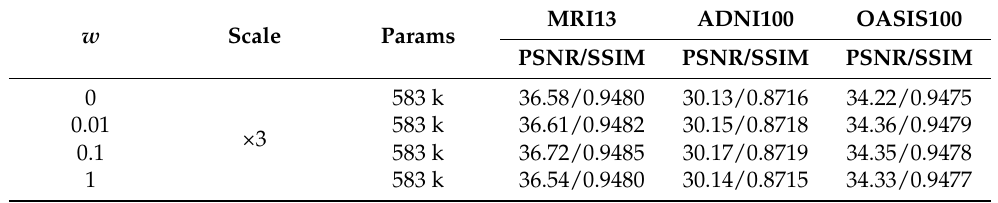
Table 1. Comparison of different weights assigned to unity feedback loss on DMFN.